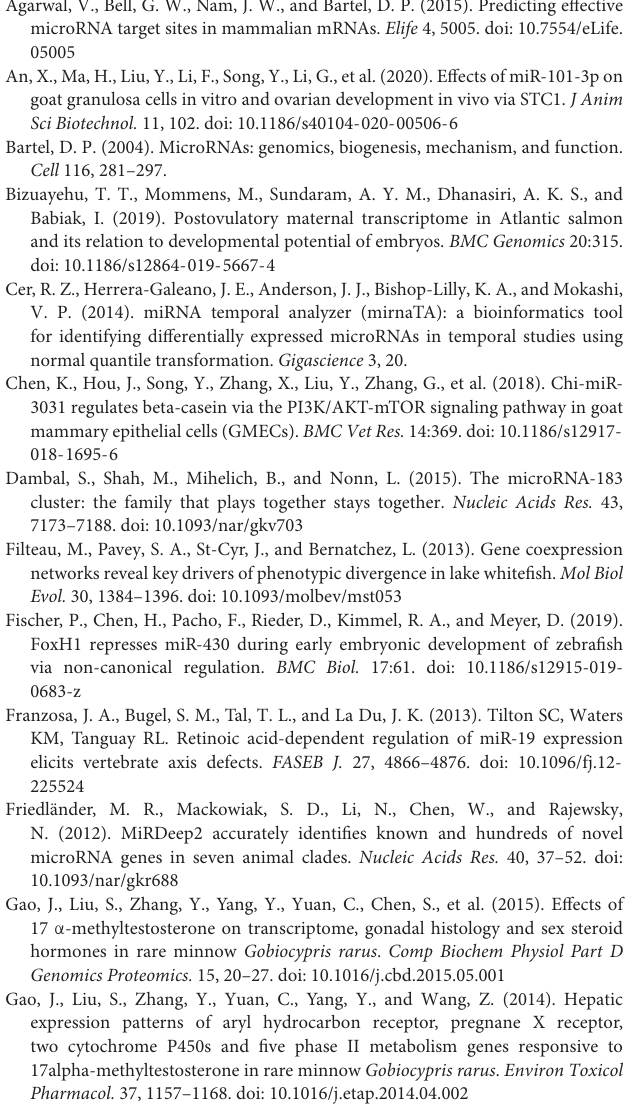
Supplementary Figure 1 | PCA analysis of RNA and miRNA. The variation between samples was constrained in the PCA analysis [ (a) 24.8 and (b) 43.7% of the overall variance for RNA and miRNA; P < 0.05]. In both panels, different colors correspond to samples from different MT concentrations. The percentage of variation explained by each axis refers to the proportion of the total data variance explained by the constrained factor. Supplementary Figure 2 | Heatmaps of RNA (a) and miRNA (b) ( n = 3). Supplementary Figure 3 | Network heatmap of RNA and miRNA. (a) Analyzing the correlation between the two modules and drawing a heat map. Each row and